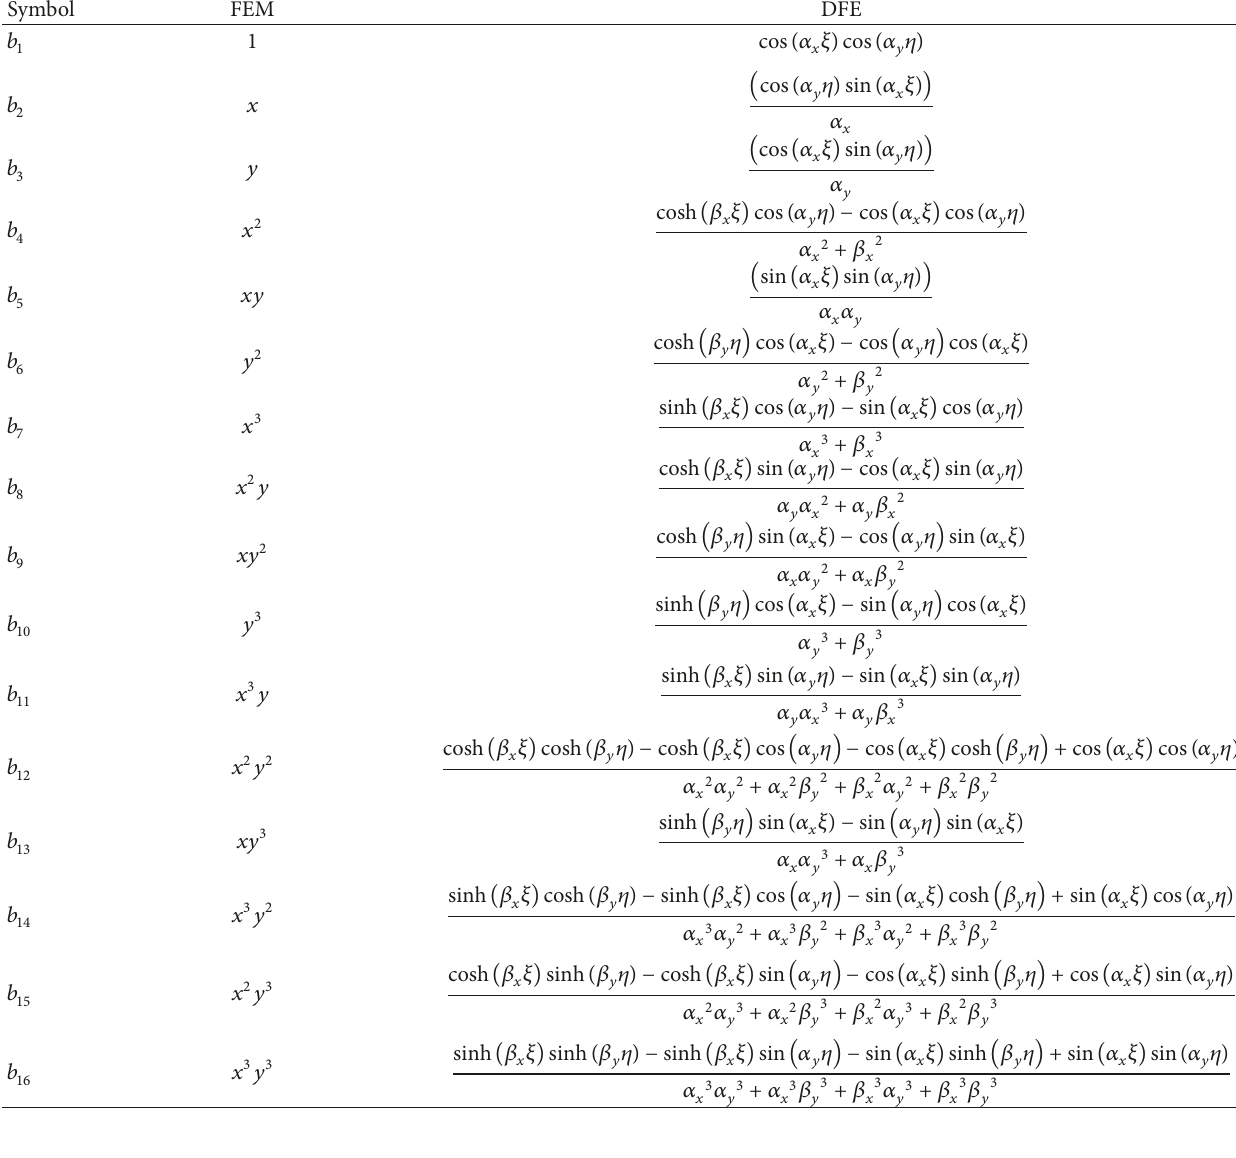
Table 1: Trigonometric basis functions for thin